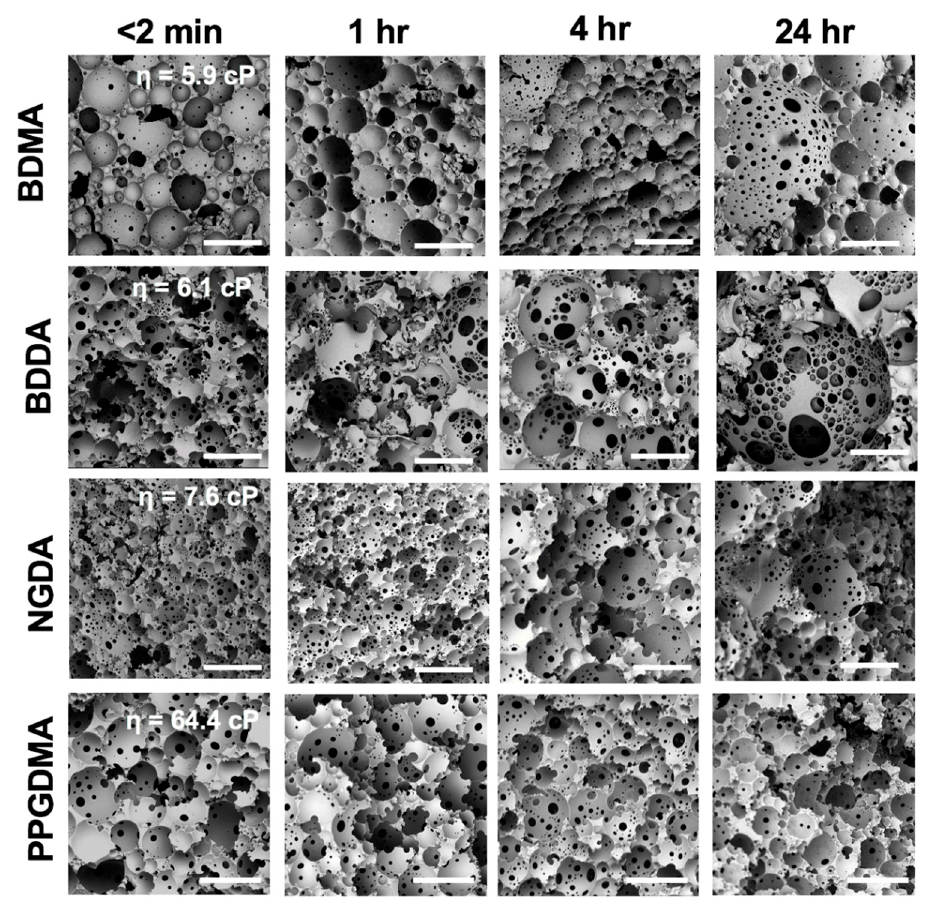
Figure 7. Representative scanning electron micrographs of fracture planes from BDMA, BDDA, NGDA, and PPGDMA polyHIPEs cured at specific time points. BDMA, BDDA, and NGDA polyHIPEs were imaged at 250× (300 µm scale bar). PPGDMA polyHIPEs were imaged at 1000× (100 µm scale bar).